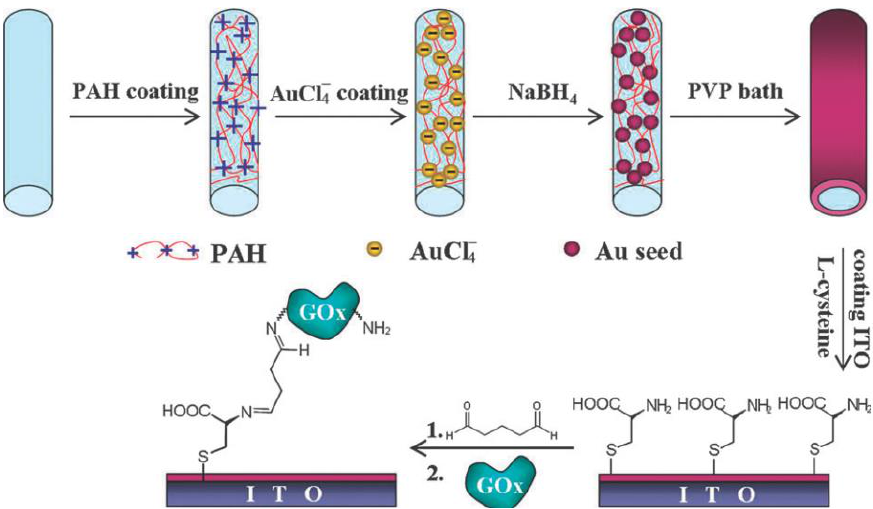
Figure 13. Schematic diagram illustrates formation of SiO 2 @Au core-shell fibers and the immobilization of GOx. Republished with permission of the Royal Society of Chemistry from [119].